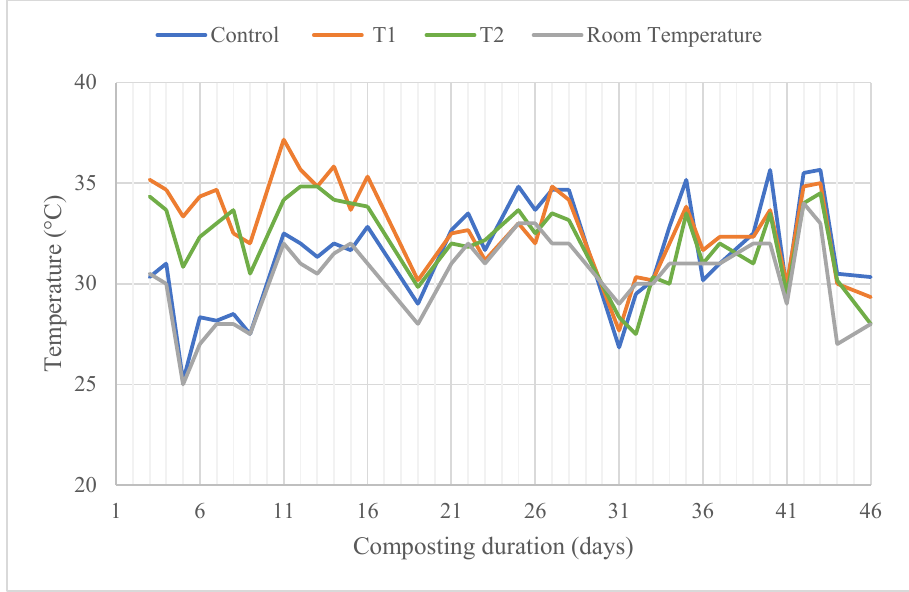
Figure 4. Temperature changes during the soil amendment composting process (lasting 45 days in total).